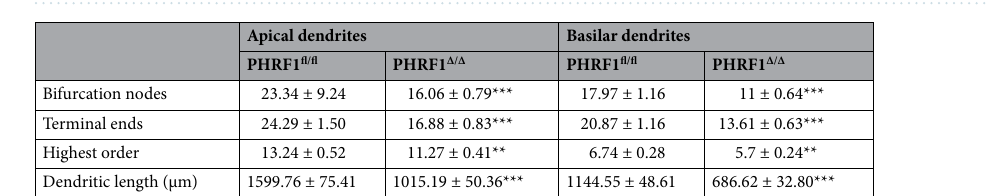
Table 1. Morphological parameters of dendritic structures. Morphometric features were compared between genotypes. n ≥ 30 neurons from 7 mice of eachgenotype. Data are mean ± SEM. **p < 0.01; ***p < 0.001. Two- tailed unpaired Student’s